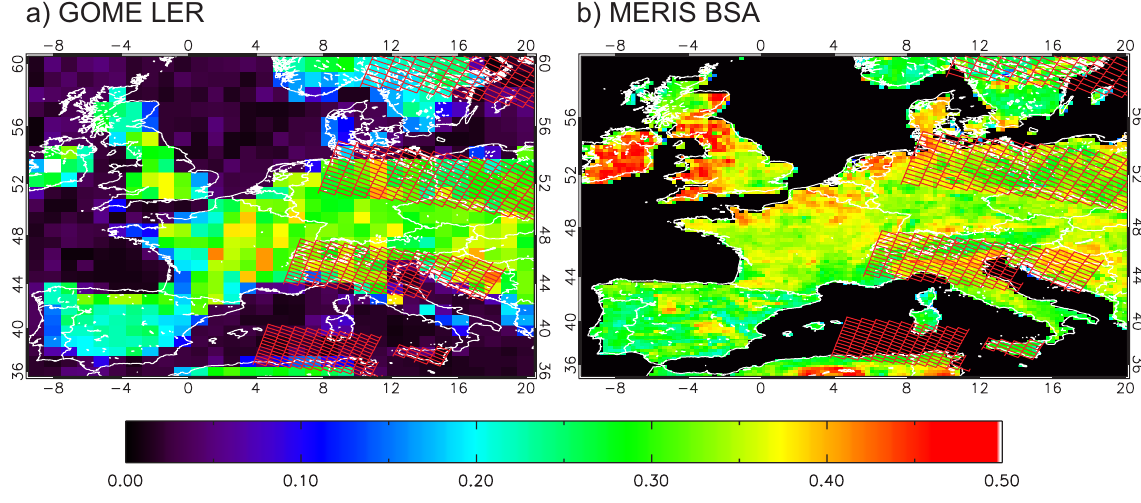
Fig. 1. Comparison between GOME LER with a spatial resolution of 1 ◦ × 1 ◦ (758nm) and MERIS BSA (754nm) with a spatial resolution of 0.25 ◦ × 0.25 ◦ for the month of July over Europe. Superimposed in red are the outlines of the SCIAMACHY pixels (30 × 60km 2 ) for an orbit from 14 July 2006. Note that no albedo values over ocean are available for the MERIS